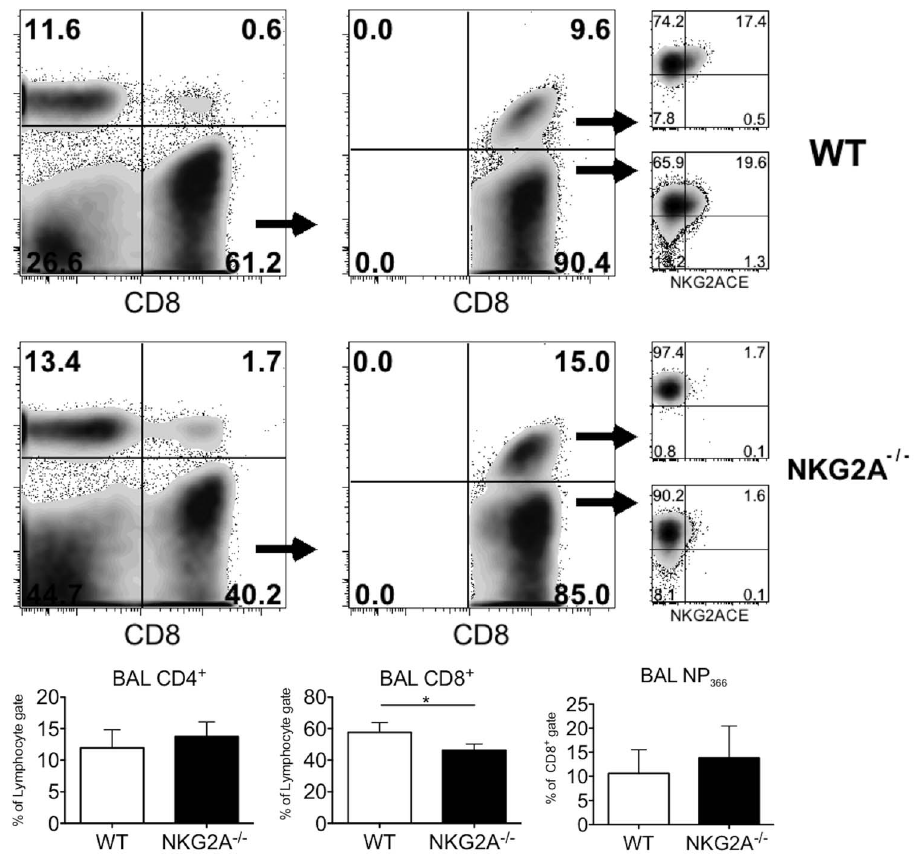
Figure 4. Expression of NKG2A on antigen specific CD8 + T cells from WT and NKG2A 2 / 2 influenza infected mice. Mice were intranasally infected with a sub-lethal dose of influenza A/PR8/34 and bronchoalveolar lavage was performed on day 10 post-infection. Isolated cells were stained with NP 366 tetramers and antibodies specific for CD44, CD8 and NKG2A,C,E or NKG2A b6 . Surface expression was determined by FACS. Average values for CD4 + , CD8 + and NP 366 specific -CD8 + T cells from a representative experiment are shown in the bar graphs below. * p , .05 Shown is a representative experiment from at least 3 experiments with 3–4 mice per group.